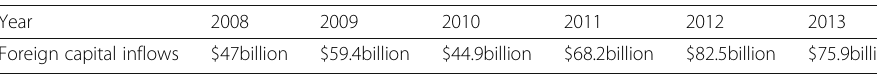
Table 1 Foreign capital flows to